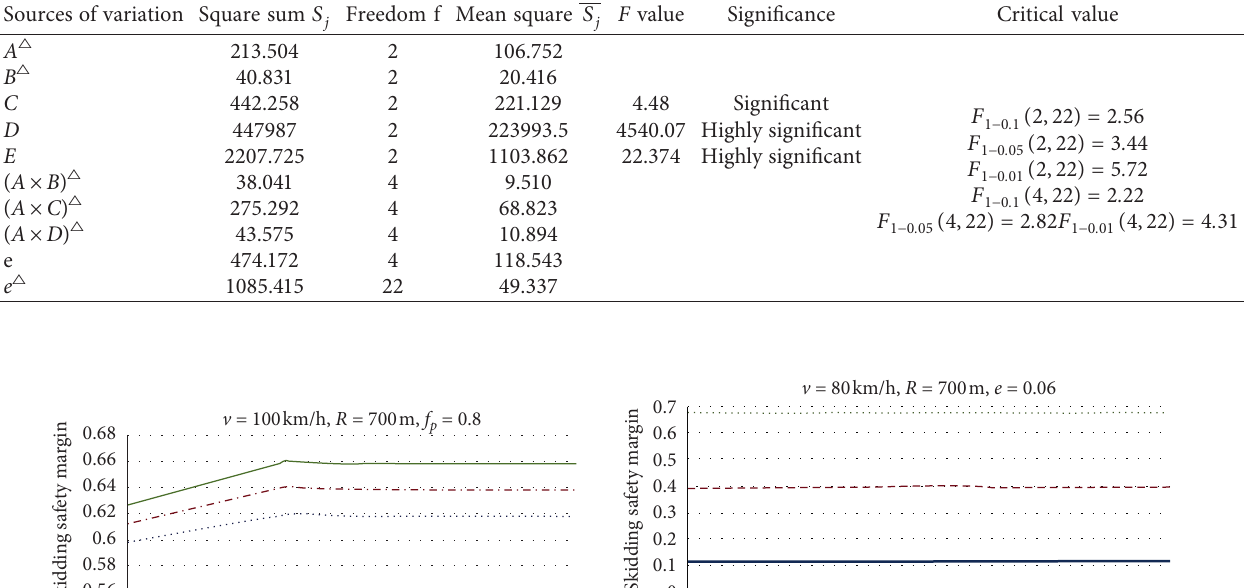
Table 10: The table of variance analysis of the safety margin of vehicle lateral drift M